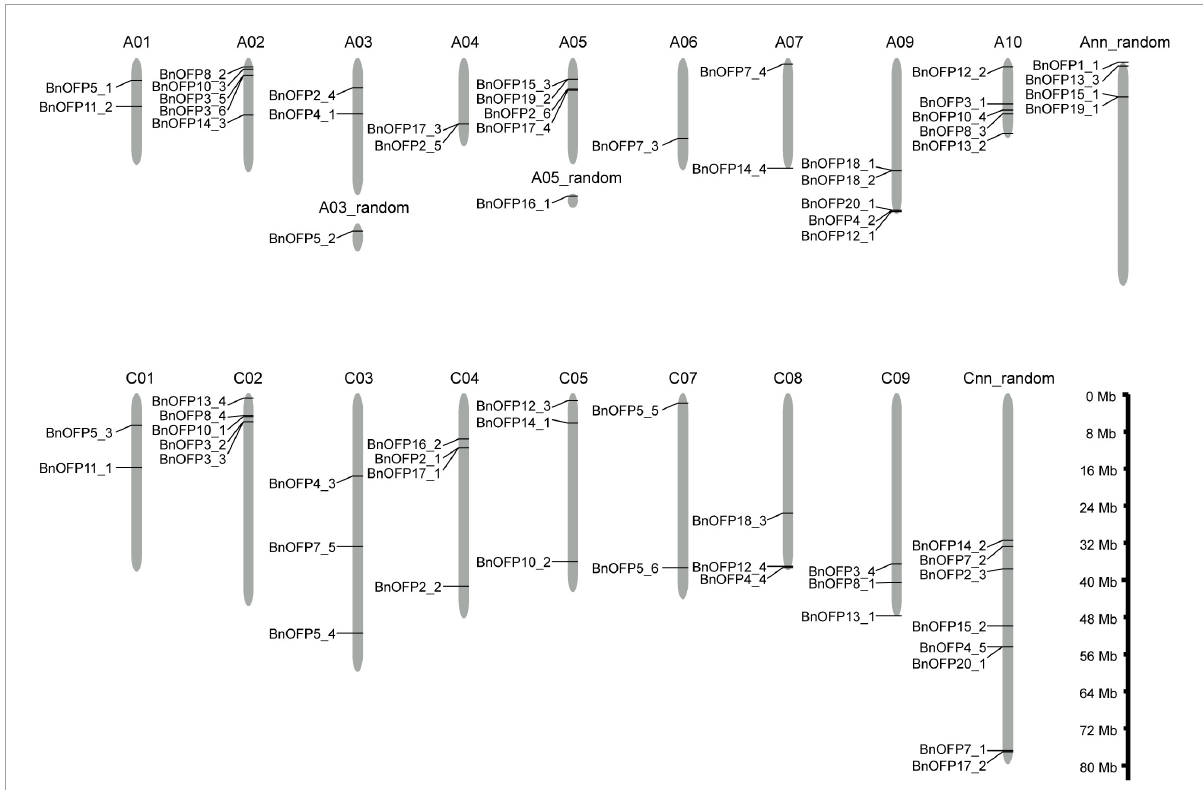
FIGURE1 Chromosomal locations of BnOFPs . The 67 BnOFP genes were located on different chromosomes of two sub-genomes. Random chromosome means that the sequence was mapped to corresponding chromosome but the physical location was unknown. Length of chromosomes is also shown in the